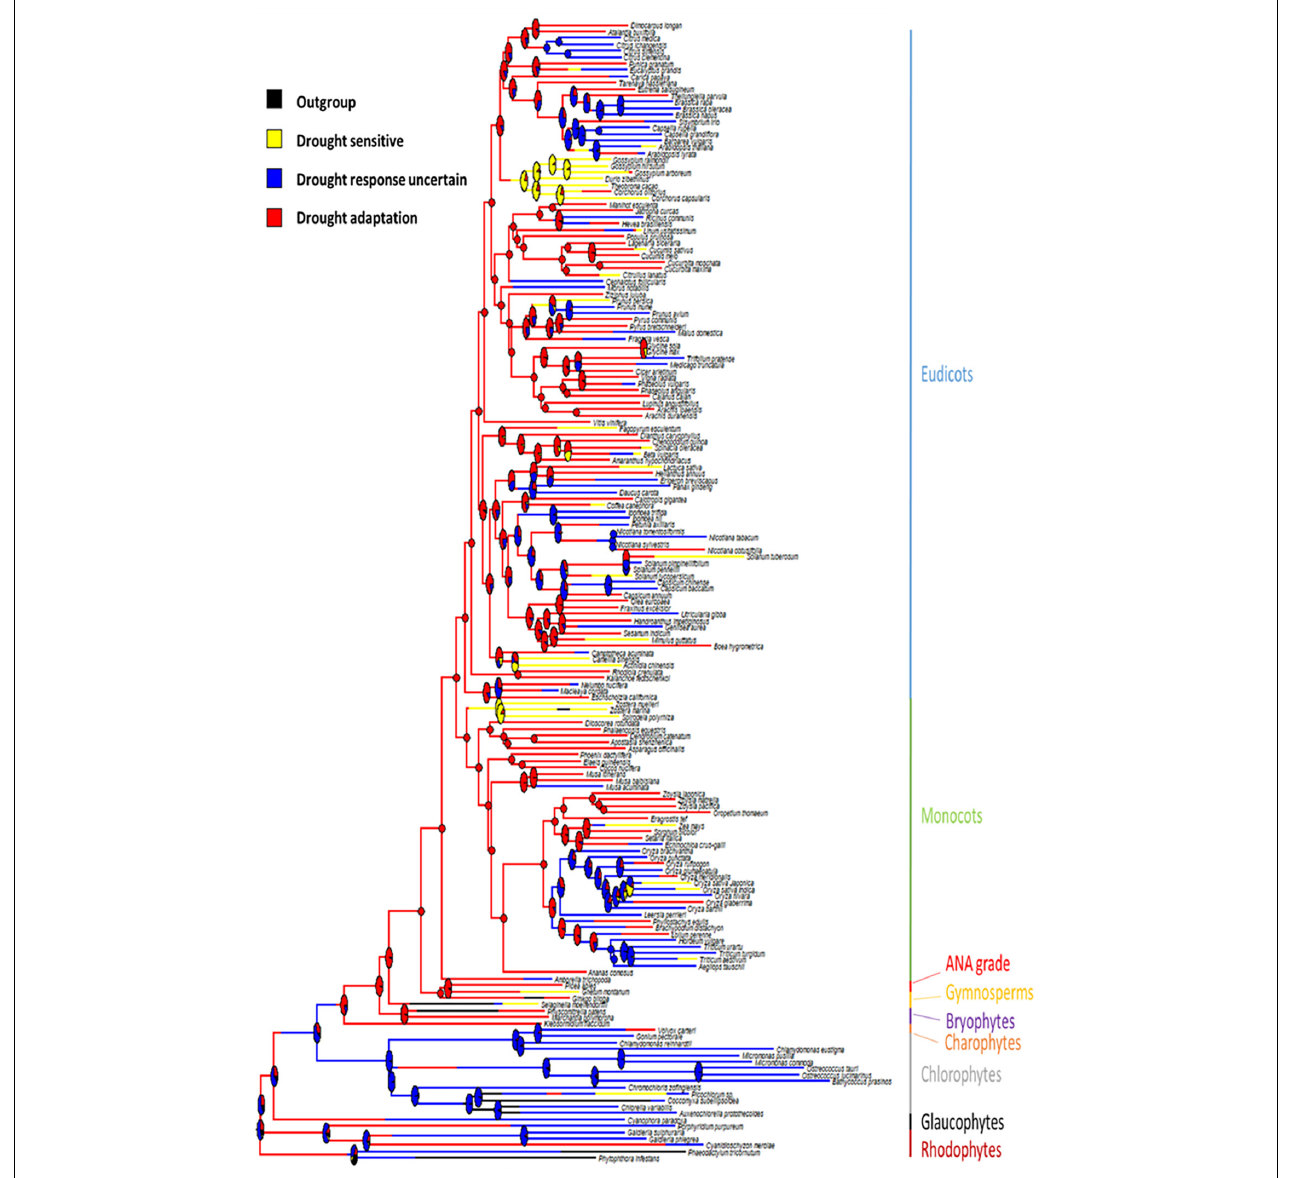
FIGURE 1 | Ancestral state reconstruction of drought adaptation on a species tree. Branches are colored by drought response status. Pie charts represent the support for the ancestral state at each internal